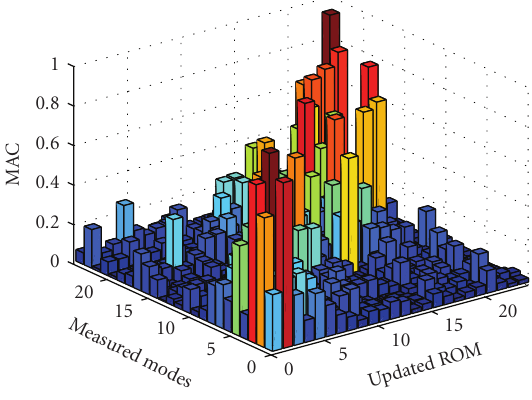
Table 1: Statistic values of identified mistuning at each iteration.